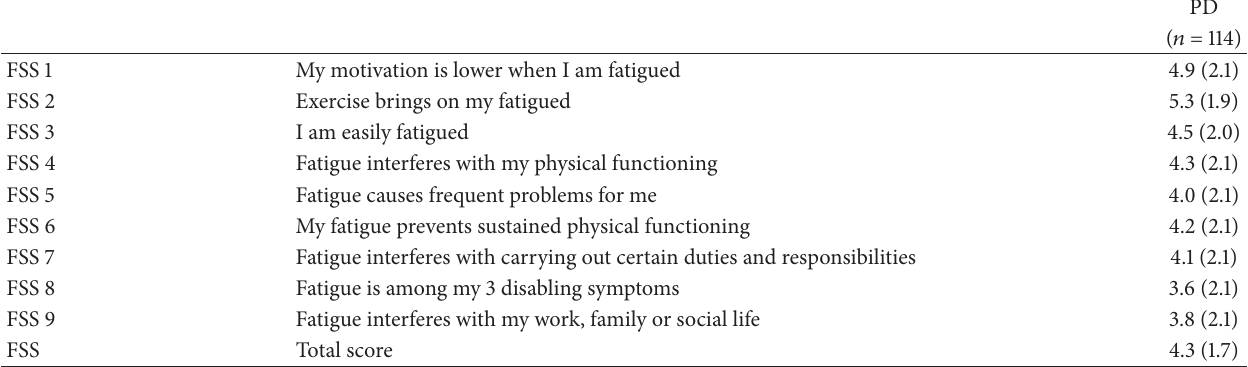
Table 1: Fatigue Severity Scale